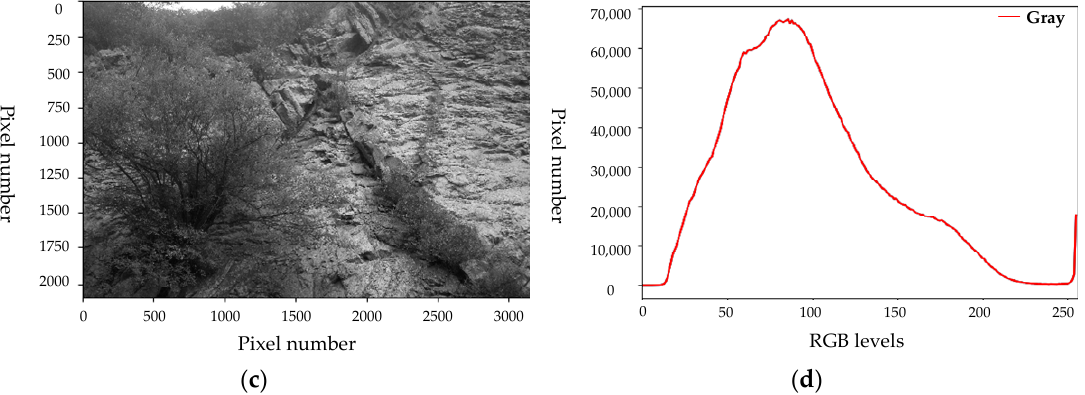
Figure 2. The histogram features extracted from color and grayscale geological structure image: ( a ) Color image; ( b ) Color image histogram; ( c ) Grayscale image; ( d ) Grayscale image histogram. The raw data is not enough for a training model using CNN and transfer learning. As a consequence, some data augmentation methods, such as channel shift, shear, flip from left to right and flip from top to bottom, were adopted to raw data, as shown in Figure 3. A channel shift means to change the general color of the whole image; shear means to keep the horizontal axis (or vertical axis) stable and translate the other axis at a ratio. The translation distance is proportional to the distance to the horizontal axis.